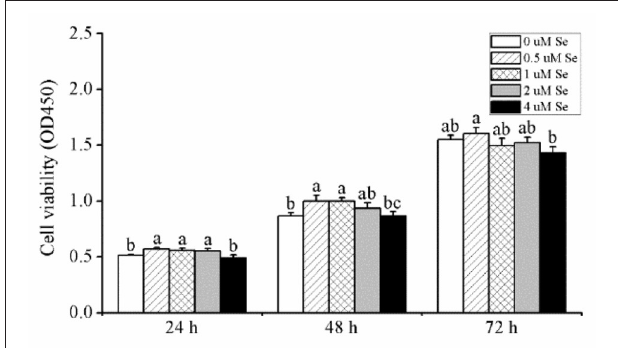
FIGURE 1 | Effects of selenomethionine (Se-Met) supplementation on cell viability in porcine mammary epithelial cells (pMECs). The cells were incubated with different concentrations of Se-Met (0, 0.5, 1, 2, and 4 µ M) for 24, 48, and 72h. Cell viability was analyzed using the CCK-8 assay. The data are expressed as the mean ± SEM ( n = 12). Different superscript letters indicate a significant difference ( p <